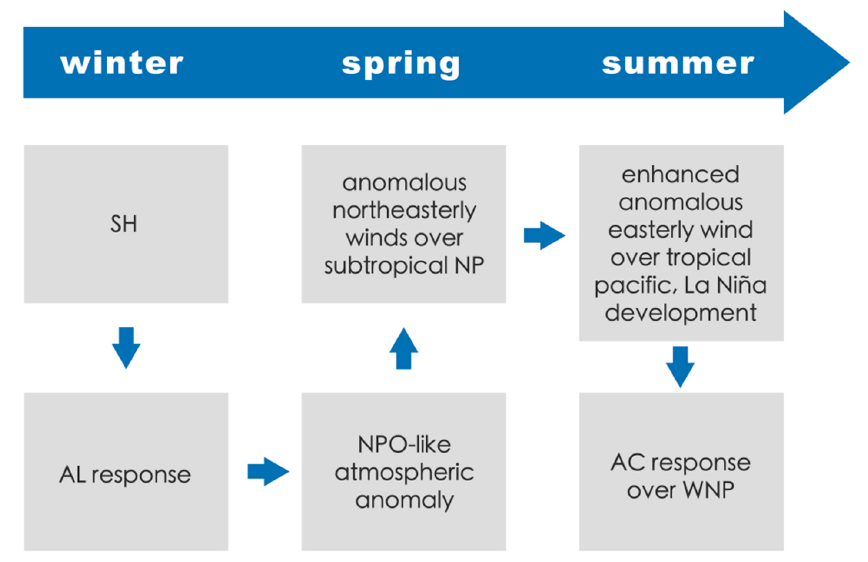
Figure 8. Mechanism diagram showing the processes linking the winter SH to the summer environ- mental background atmospheric circulation anomaly associated with WNP TCGF during P1.